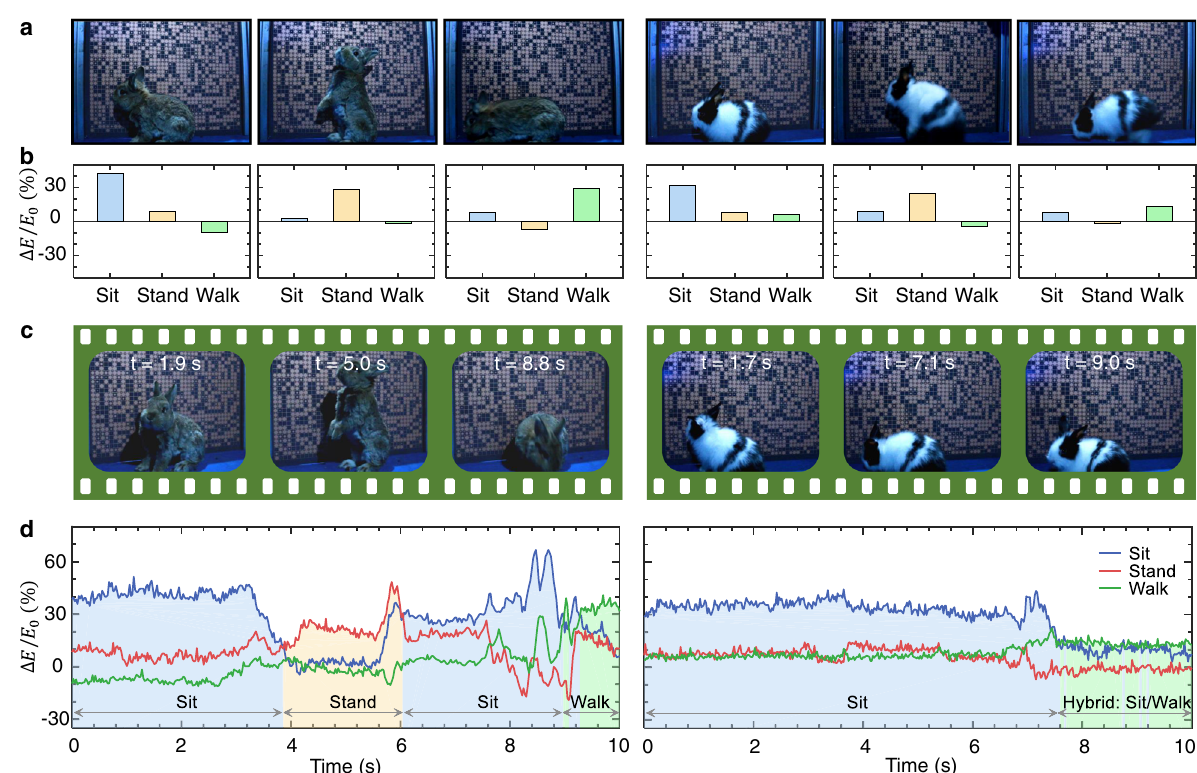
Fig. 3 Experimental results showing real-time recognition of the postures of two rabbits. a Snapshots of two rabbits having different postures and sizes, corresponding to the average experimental results in b . We quantify the accuracy of the results using the variance of the electric fi eld amplitude over its original amplitude, that is, 4 E = E 0 . c Snapshots of two freely-playing rabbits; see the full videos in Supplementary Movies 1 and 2. d Experimental time- varying results. For the gray rabbit (left), the signal varies dramatically, where the three postures are clearly observed. For the smaller black-white rabbit (right), the signal remains relatively stable and shows hybrid postures toward the